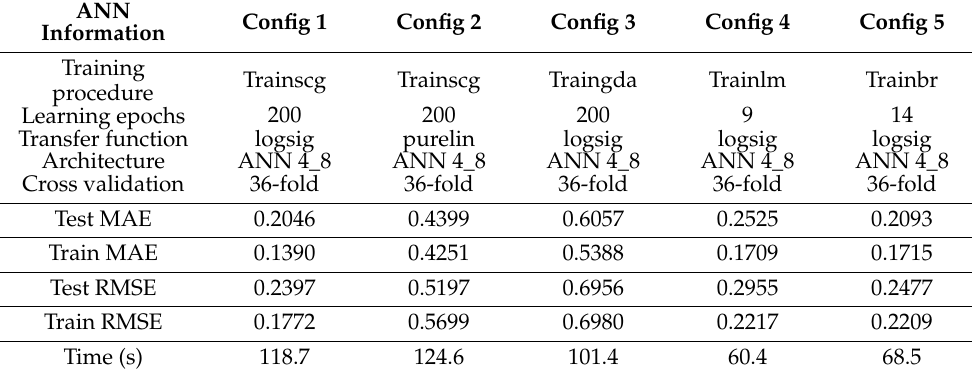
Table 6. Tested feed-forward ANN configurations.